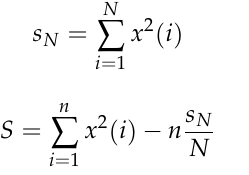
6 of 12 Table 1. AE signal characteristics. Extracted Features